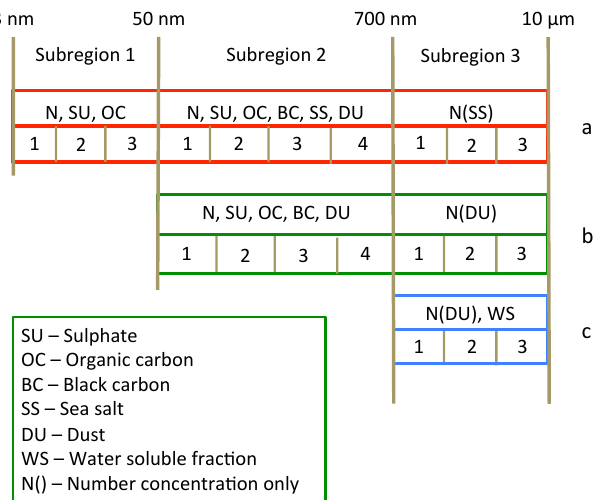
Table 1. Particle diameter limits within all sections in SALSA. Please note that the limits in parallel size bins are the